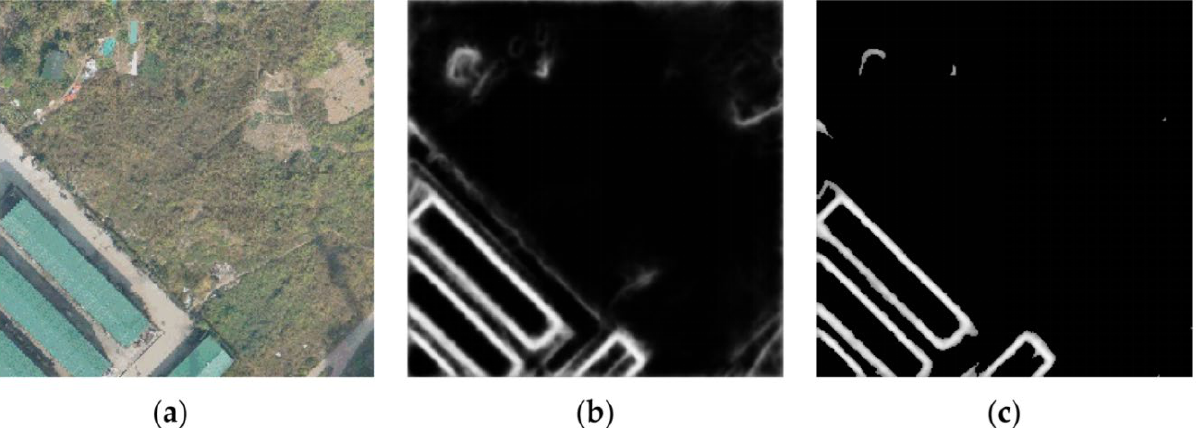
Figure 7. An example of Jiangbei New Area dataset: ( a ) raw image; ( b , c ) different building edge probability predictions with the same strict F1-score.